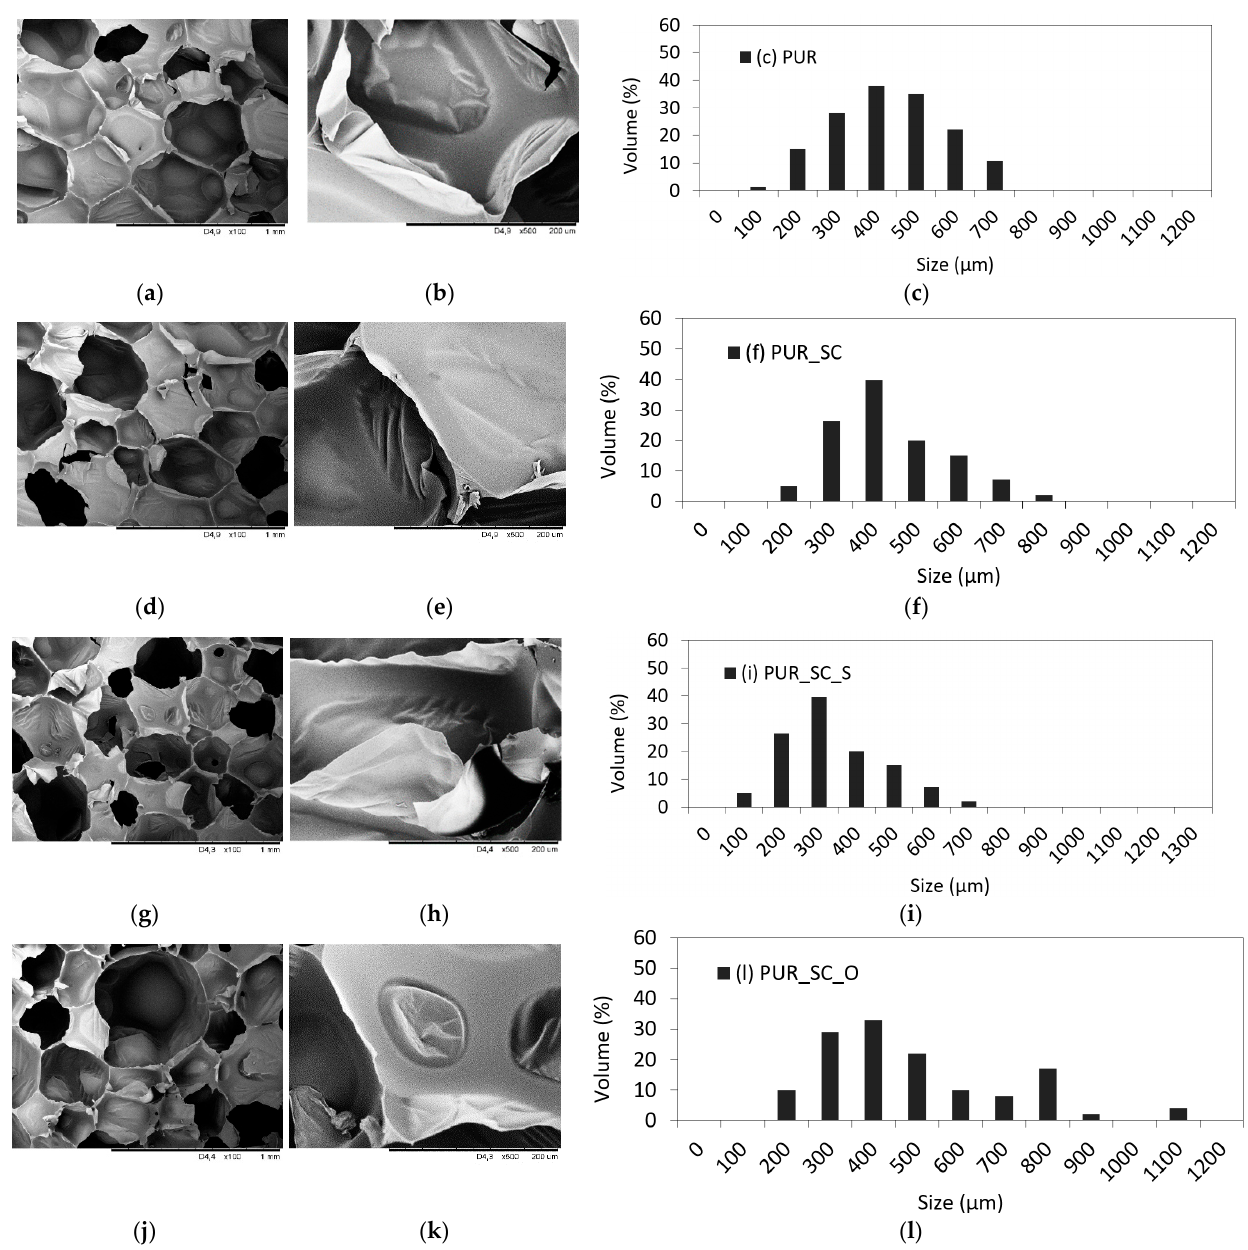
Figure 2. Cellular morphology and cell size distribution of ( a – c ) PUR; ( d – f ) PUR_SC; ( g – i ) PUR_SC_S; ( j – l ) PUR_SC_O.